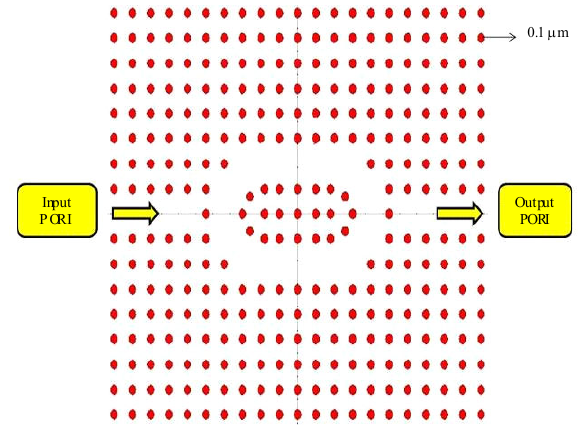
Fig. 1 Proposed biosensor using elliptical ring resonator.